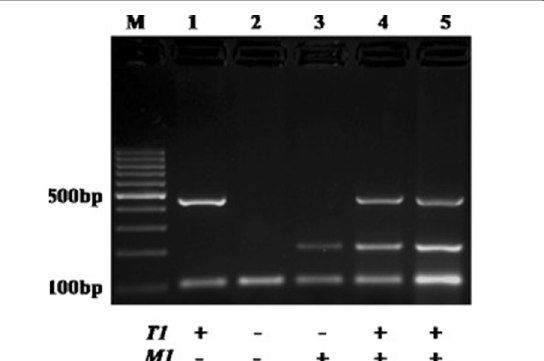
Fig. 2 PCR multiplex products resolved on 3% agarose gel, stained with ethidium bromide. Amplicons of 230 bp and 480 bp indicate, respectively, the presence of GSTM1 and GSTT1 . A band at 110 bp, corresponding to β ‑ globin